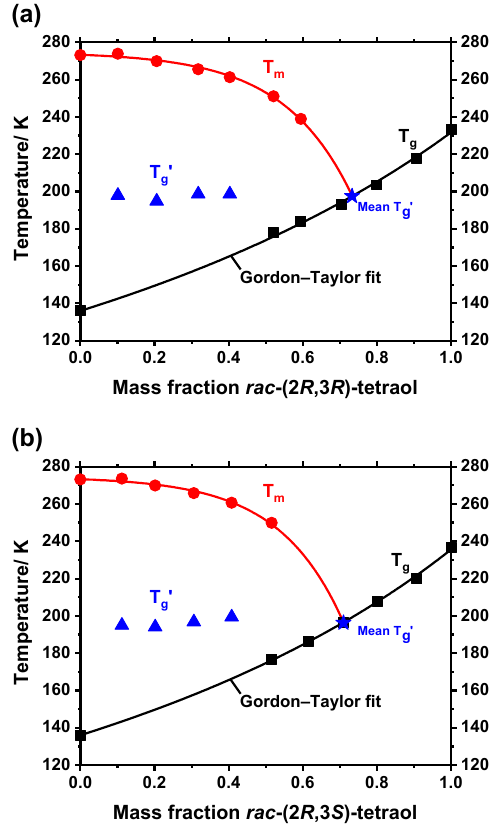
Figure 2. Partial phase diagram of mixtures of rac -(2 R ,3 R) -tetraol with water (a) and rac -(2 R ,3 S )-tetraol with water (b) . Shown are the ice melting temperatures T m (red circles), glass transition tem- peratures T g (black squares), and maximally freeze-concentrated glass transition temperatures T (cid:48) g (blue triangles). The melting tem- peratures are fitted with an exponential function and the glass transi- tion temperatures are fitted with the Gordon–Taylor equation yield- ing a Gordon–Taylor constant of k GT = 1 . 53 ± 0 . 08 (a) and k GT = 1 . 58 ± 0 . 05 (b) , respectively. The T (cid:48) g values are plotted at the over- all mass fraction of the solution before cooling. The composition of the amorphous fraction of a sample after the water partly crystal- lized is depicted as the mean T (cid:48) g shifted towards the Gordon–Taylor fit (blue star) with a value of 197K for the rac -(2 R ,3 R) -tetraol and 196K for the rac -(2 R ,3 S)